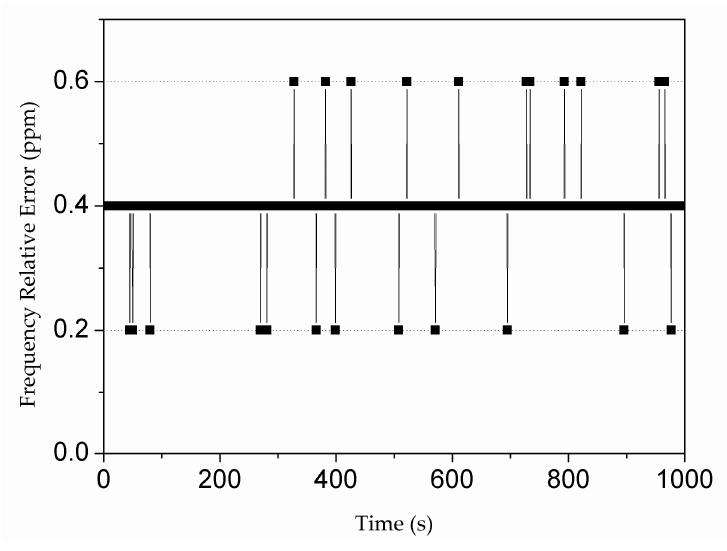
Figure 6. Frequency relative error for 10 MHz (a measurement of 1000 s).